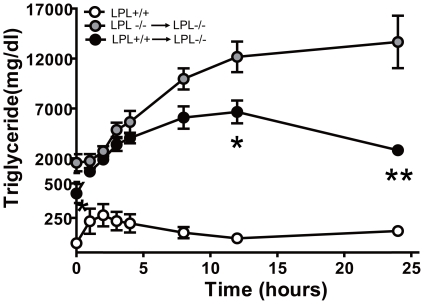
Effects of hematopoietic cell-derived LPL on clearance of intragastric fat load.Each group mice were received an oral fat load test and plasma TG levels were determined at the respective time points. Values were expressed as means ± SEM. * p<0.05, ** p<0.01, for LPL+/+→LPL-/- mice compared to LPL-/- → LPL-/- group, respectively.